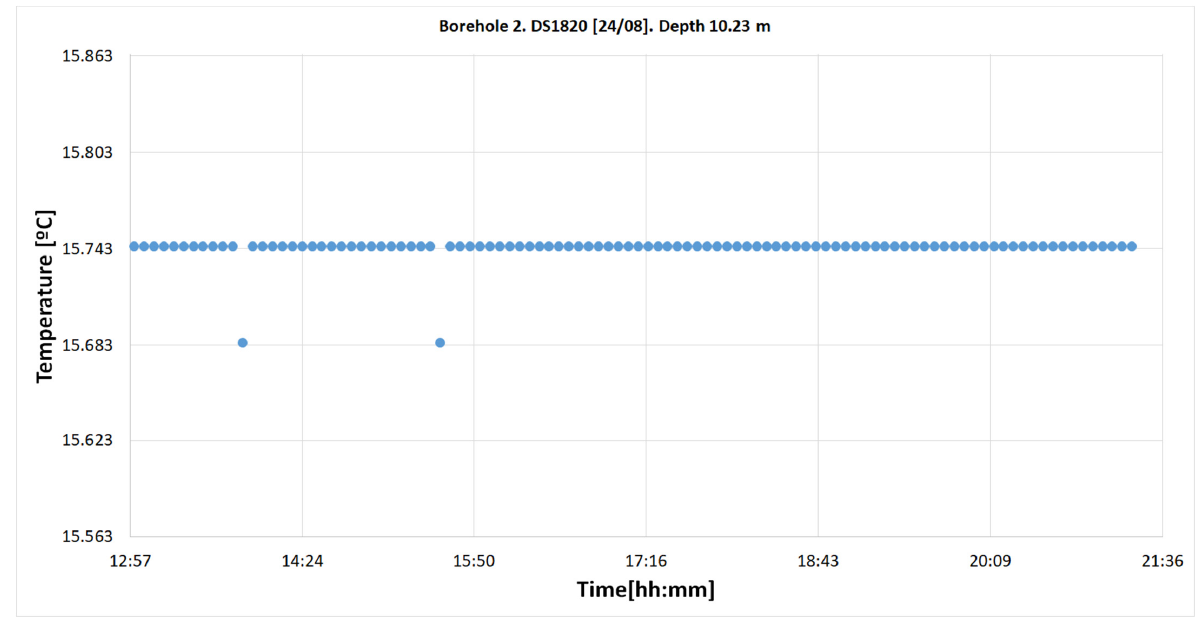
Figure 31. Temperature register on 23 August in the “Q-Thermie-Uniovi-2” borehole with DS18B20 sensor at 10.31 m, obtained via interpolation.